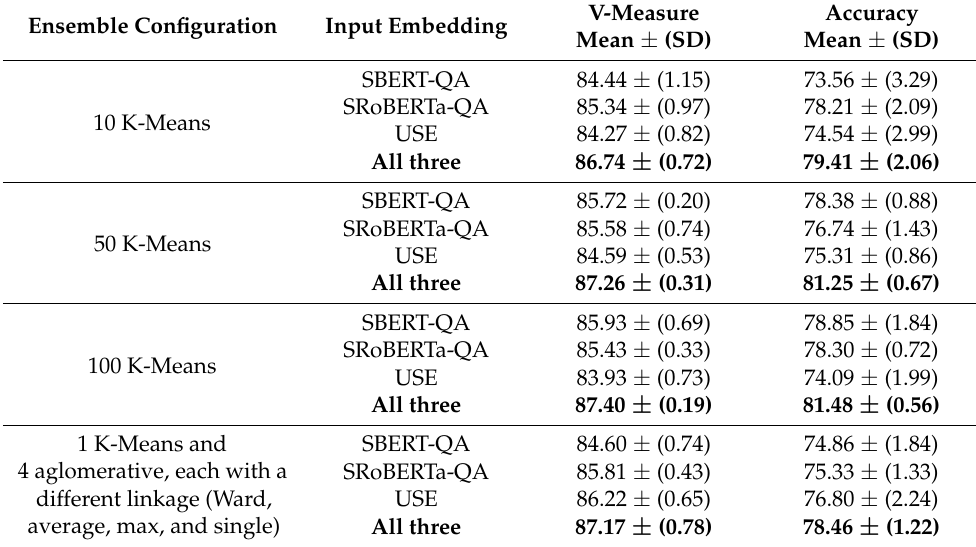
Table 6. Results (in %) of the ensemble-based